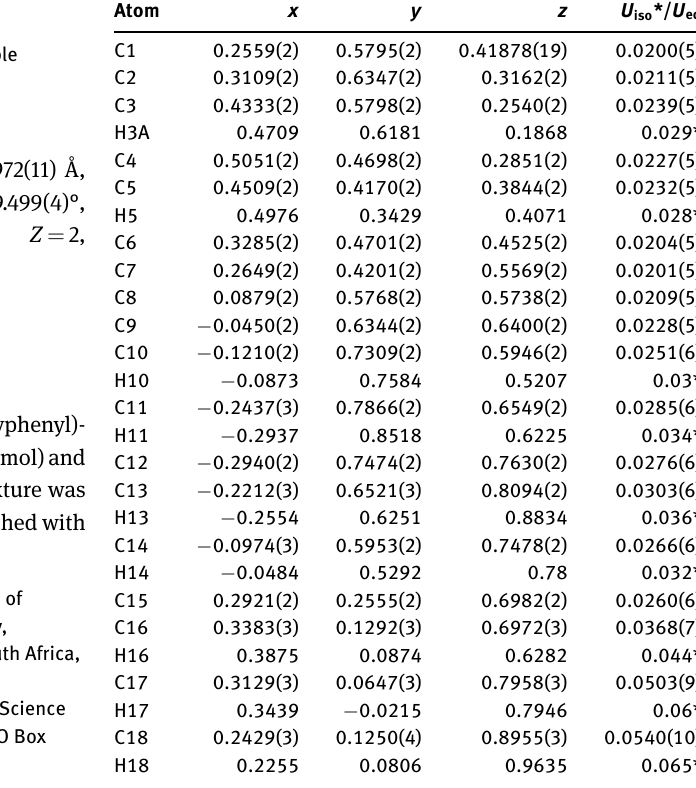
Table 2: Fractional atomic coordinates and isotropic or equivalent isotropic displacement parameters (Å 2